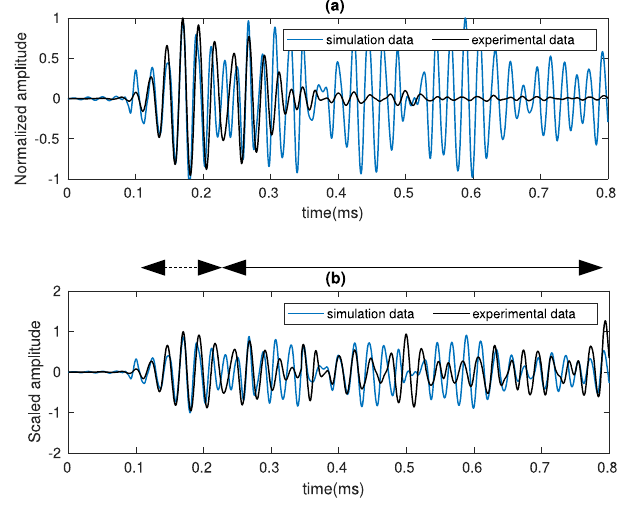
Figure 7. Comparison of the acceleration signals recorded in the experiment (black) and the simulation (blue) for a source elevation of 25 (cid:3) (a) with the normalized amplitude and (b) with the scaled normalized amplitude. Dashed and solid arrows mark the direct arrival and coda windows, respectively.